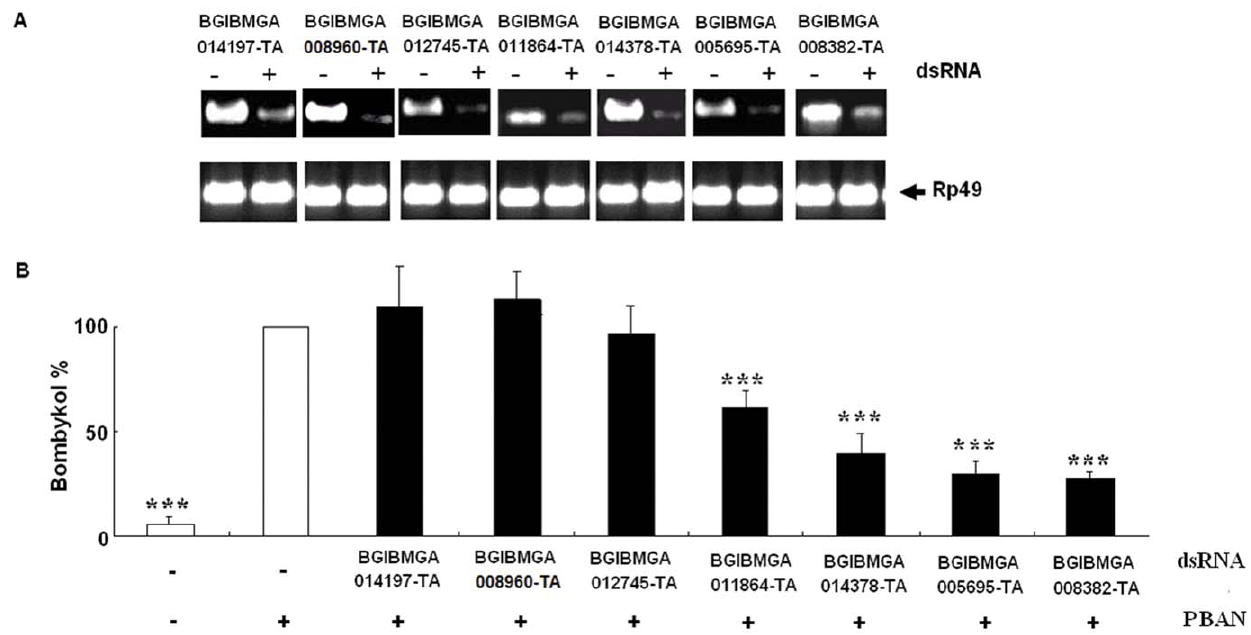
Figure 7. Effects of RNAi treatment on bombykol production. A: RNAi-induced reduction of seven putative lipase genes. RT-PCR was carried out using cDNA generated from the total RNA extracted from PGs of females injected with 20 m g dsRNAs for seven lipase genes and DEPC-treated nuclease-free water (Control). B: Effects of RNAi for seven lipase genes on bombykol production. Newly emerged females were decapitated and injected with double stranded RNAs. Decapitated females were injected with 5 pmol PBAN 30 h after dsRNA injection. Bombykol production was measured by GC/MS from PGs 90 min after injection of PBAN. Bars indicate the mean values 6 S.D. for independent experimental animals (n . =6). Statistically significant differences from the PBAN alone are denoted by *** (p , 0.001) as determined by the Student’s t -test